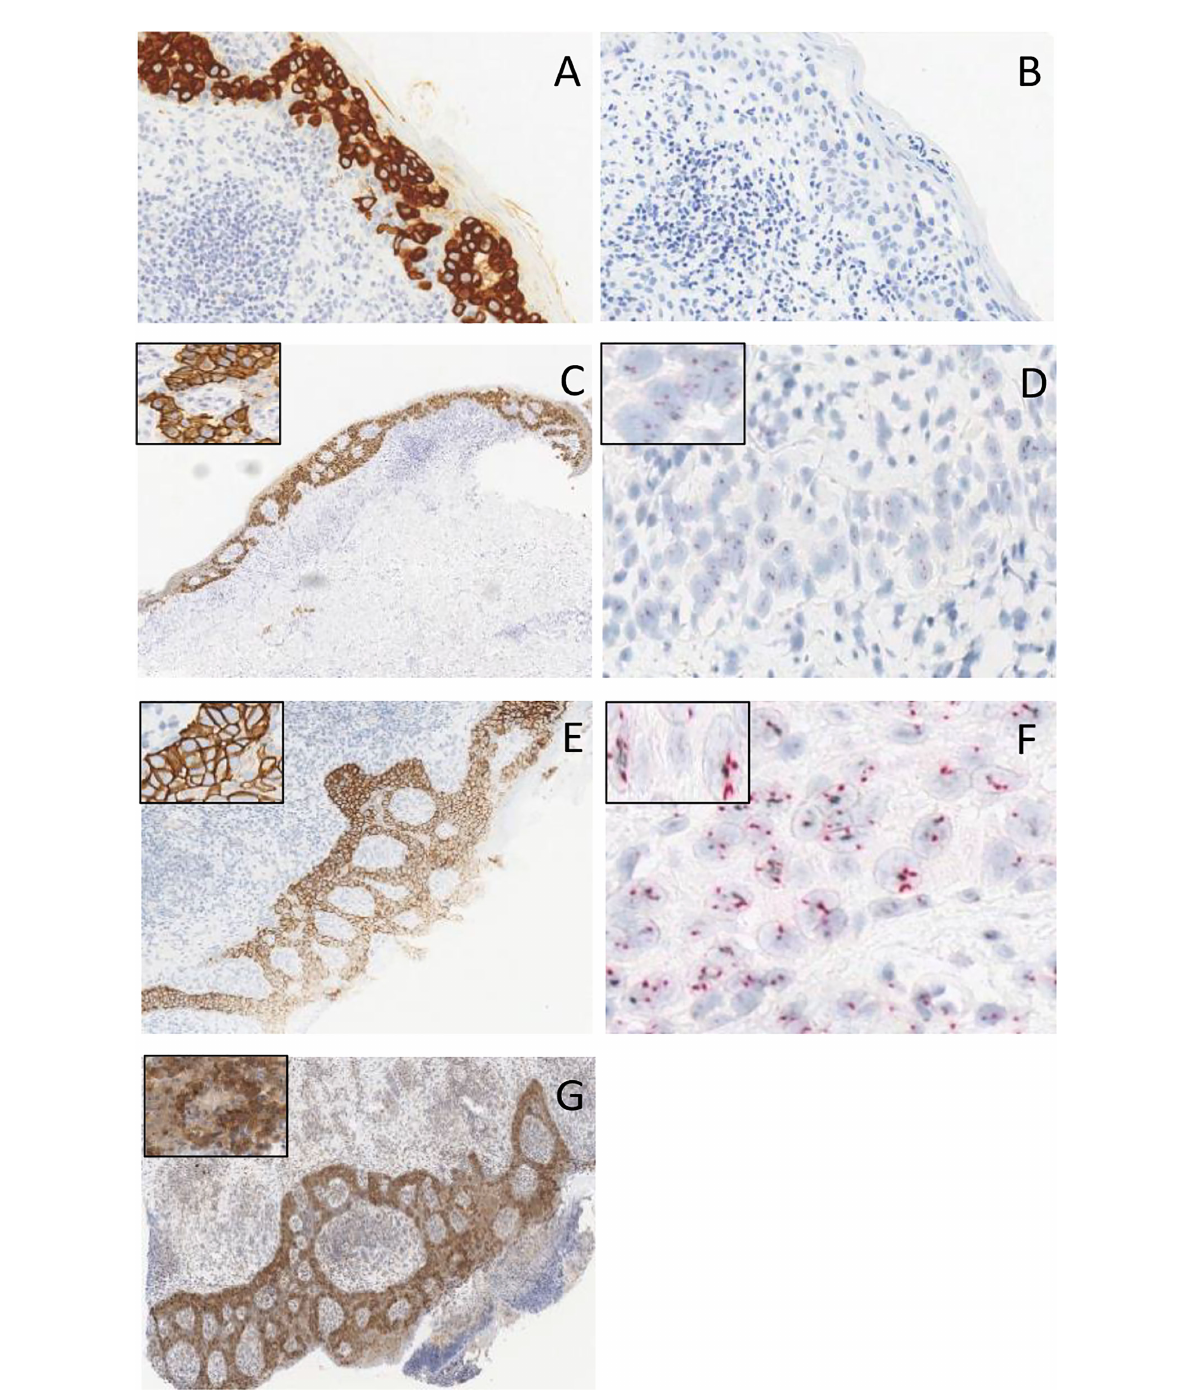
FIGURE 2 (A) Immunoreactivity for cytokeratin 7. (B) Negativity for cytokeratin 20. (C, E) HER2 strong membranous staining (3+) at immunohistochemical stain magni fi cation, × 10, in two different tumor samples of the patient. (D, F) microscopic image in CISH for HER2 staining in two different tumor samples of the patient. (G) Androgen receptor staining at immunohistochemical stain magni fi cation, ×